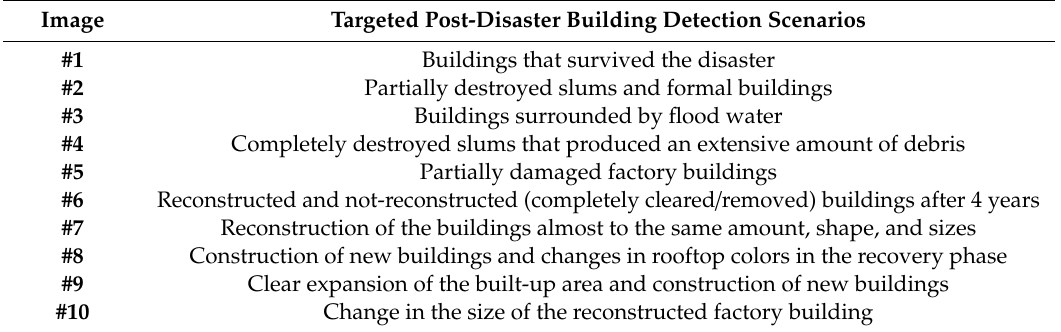
Table 1. The targeted post-disaster building detection scenarios for each selected test images. Image